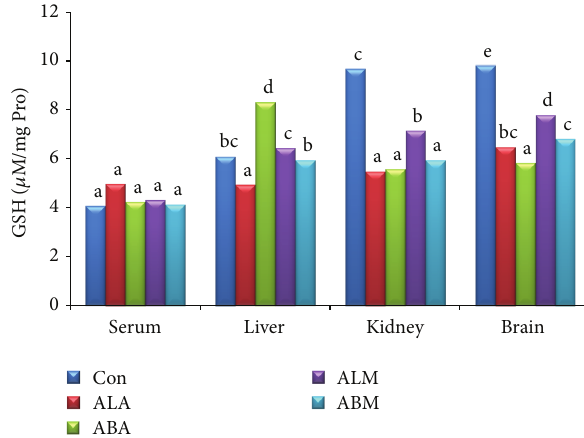
Figure 5: Glutathione levels of control and extract treated groups ( 𝜇 Mmg −1